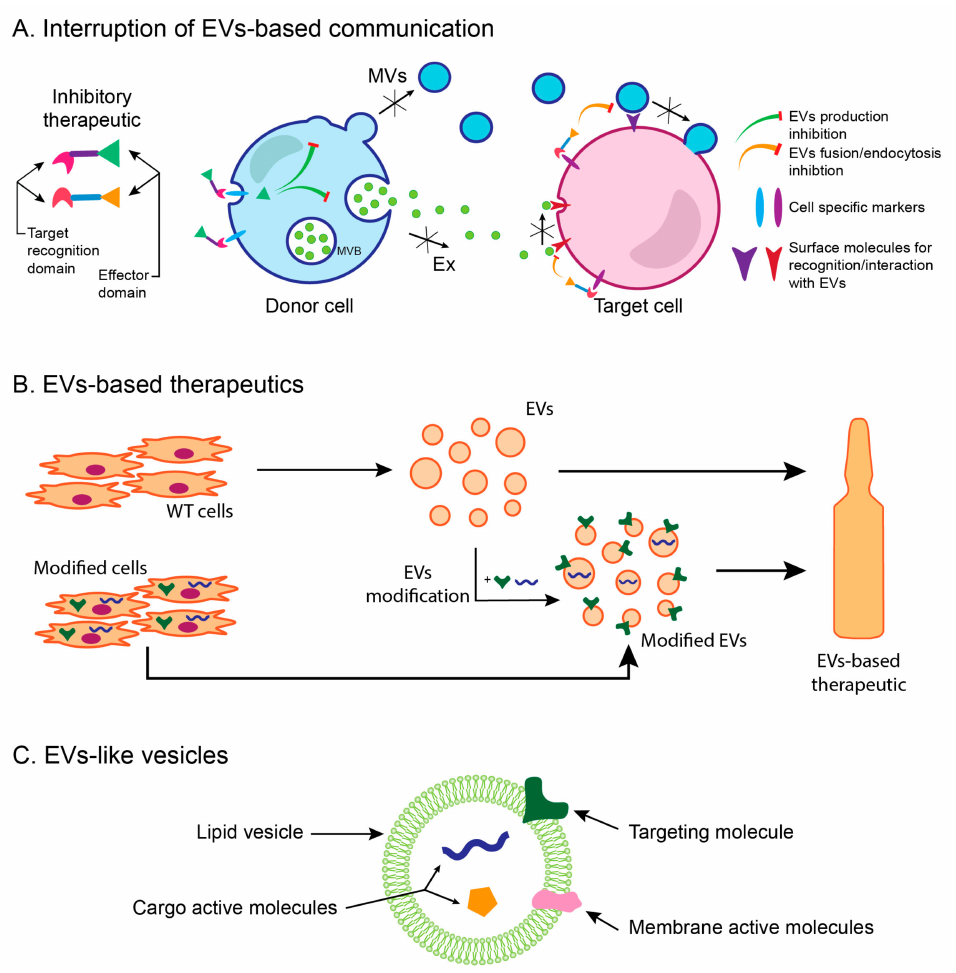
Figure 3. EV-targeted/based therapeutic approaches. ( A ) In the first approach, an interruption of EV-based communication between cells can be achieved by different chemical compounds that inhibit specific pathways of EV biogenesis or uptake. However, those compounds may exert their effects in a nonselective manner, thus affecting every cell in the organism that comes in contact with them. This issue could be resolved by combining chemical compounds with targeting moieties. ( B ) In the second approach, EVs can be used as therapeutics, either in their native form (such as MSC-EVs) or after their modification (loading with drugs, miRNA, and/or target molecules). These modifications can be achieved by direct manipulation of isolated EVs or by engineering the cells that produce